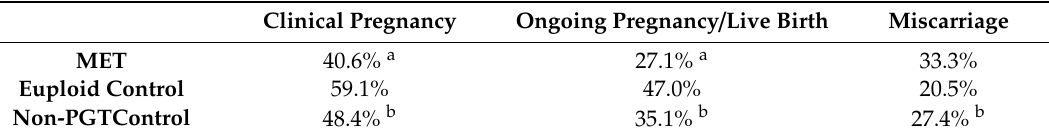
Table 2. Pregnancy outcome variation between